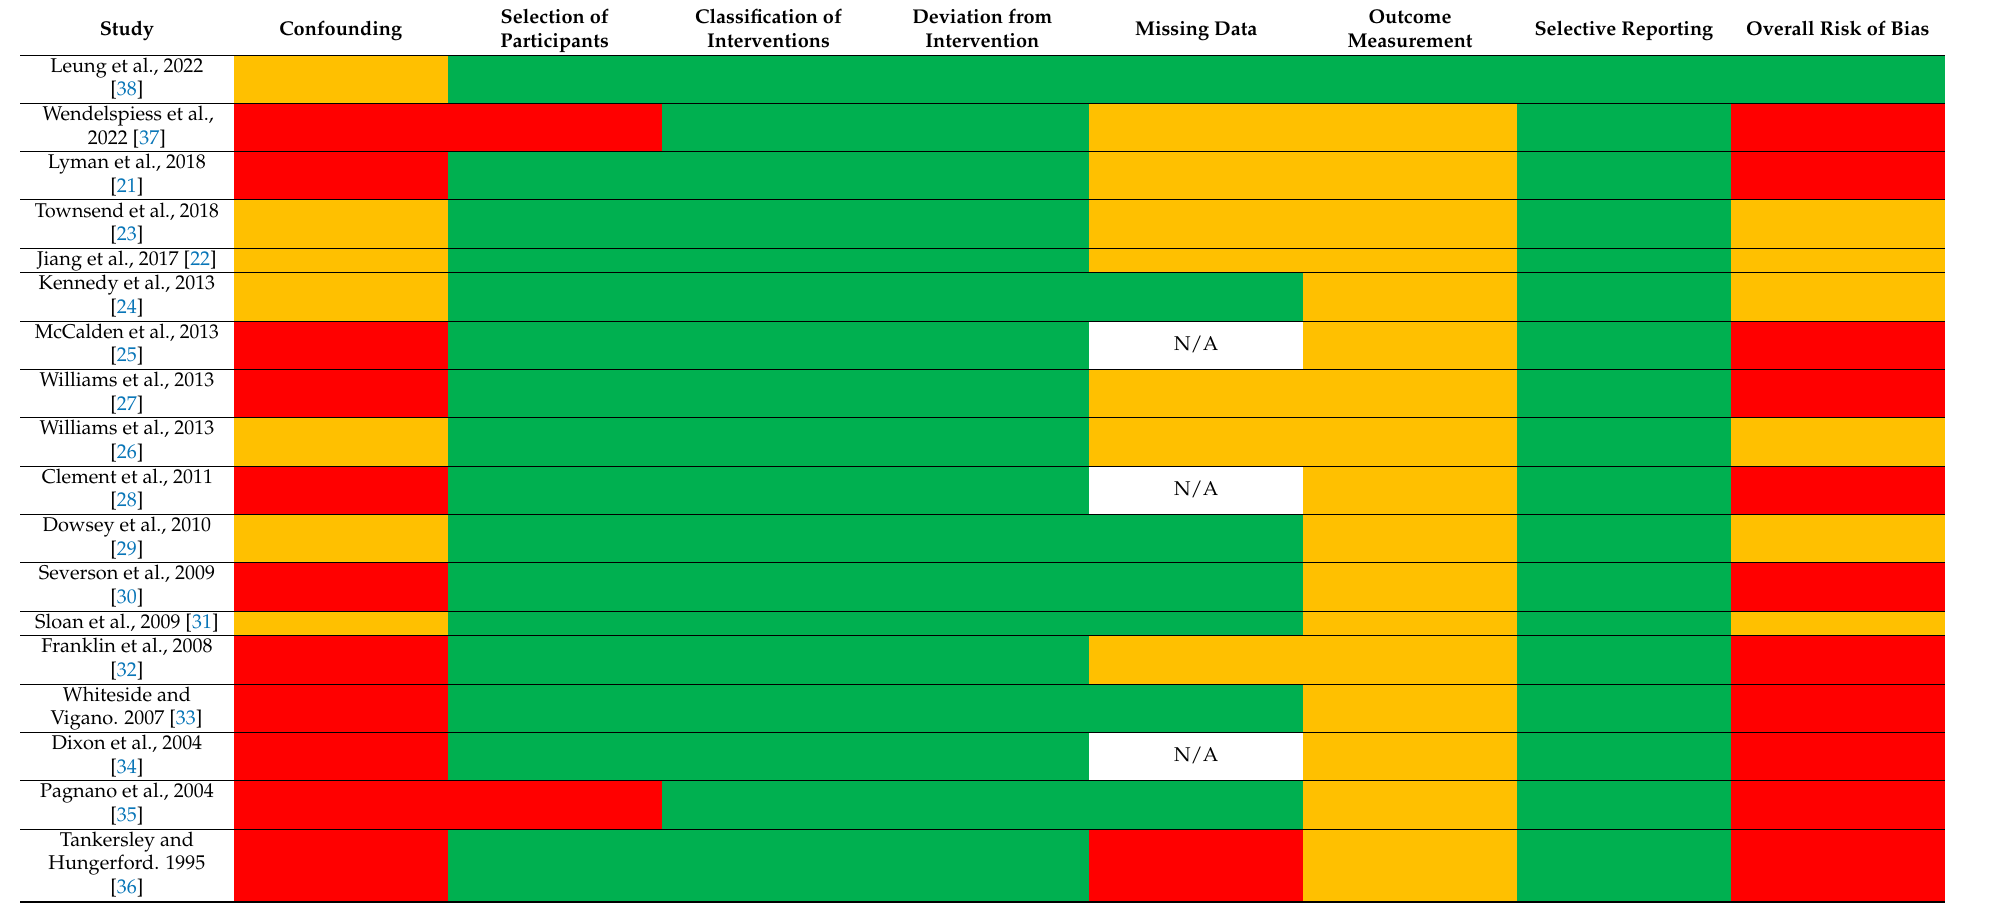
Table 2. Assessment of methodological